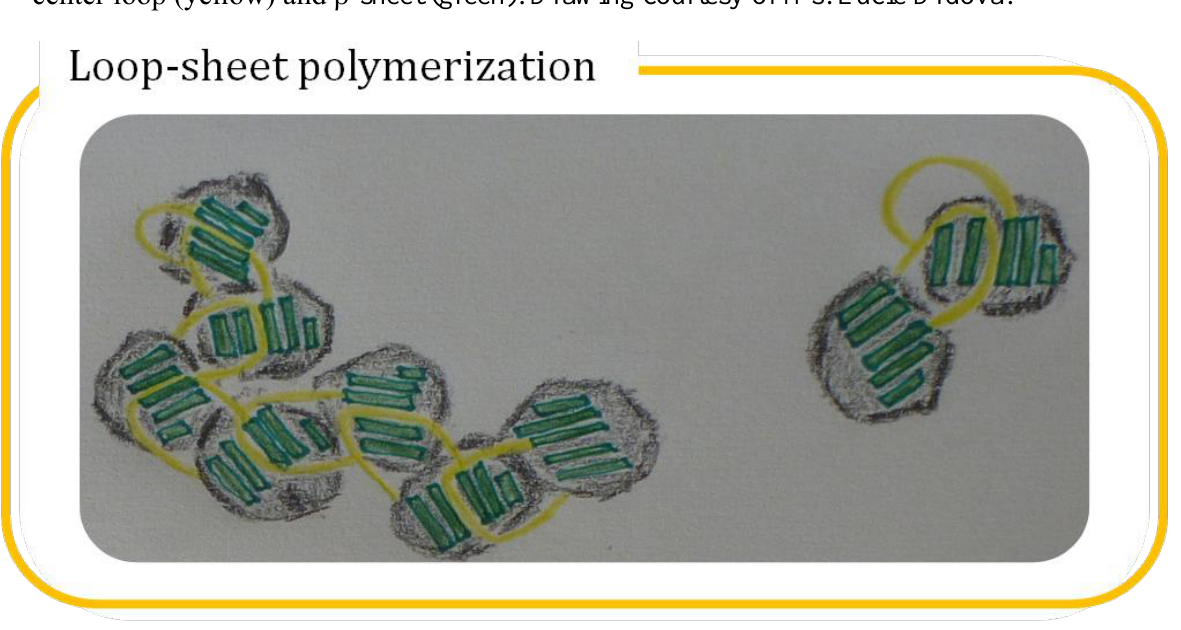
Figure 2. Loop-sheet polymerization of α -antitrypsin (AT). This abstract sketch illustrates 1 how a dimer and an oligomer of several AT molecules are linked through their reactive center loop (yellow) and β-sheet (green). Drawing courtesy of Ms. Lucie